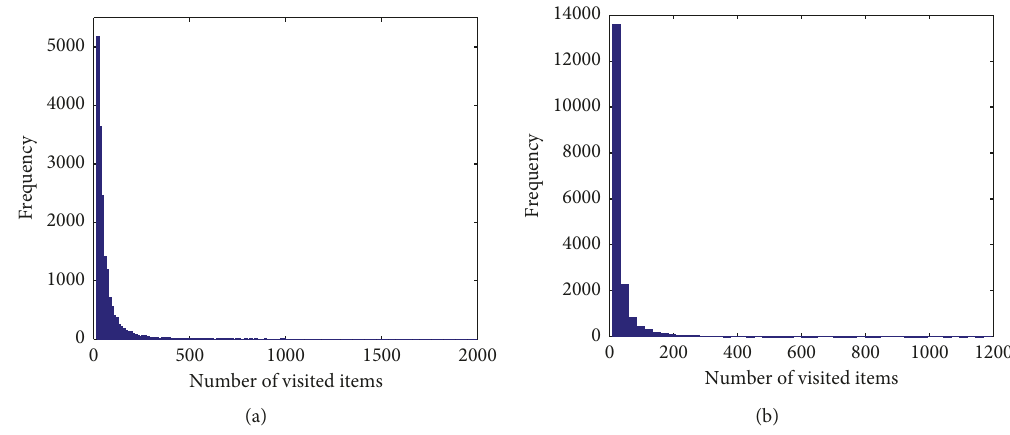
Figure 1: The histogram of users’ visited POIs: (a) Gowalla and (b)